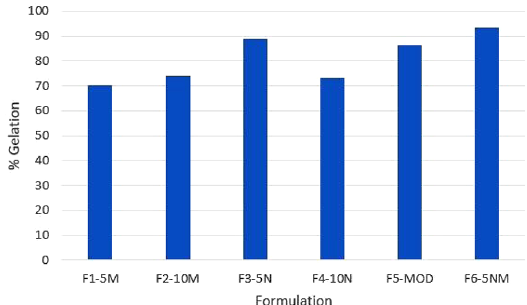
Figure 8. Degree of gelation of formulations F1-5M, F2-10M, F3-5N, F4-10N, F5-MOD, and